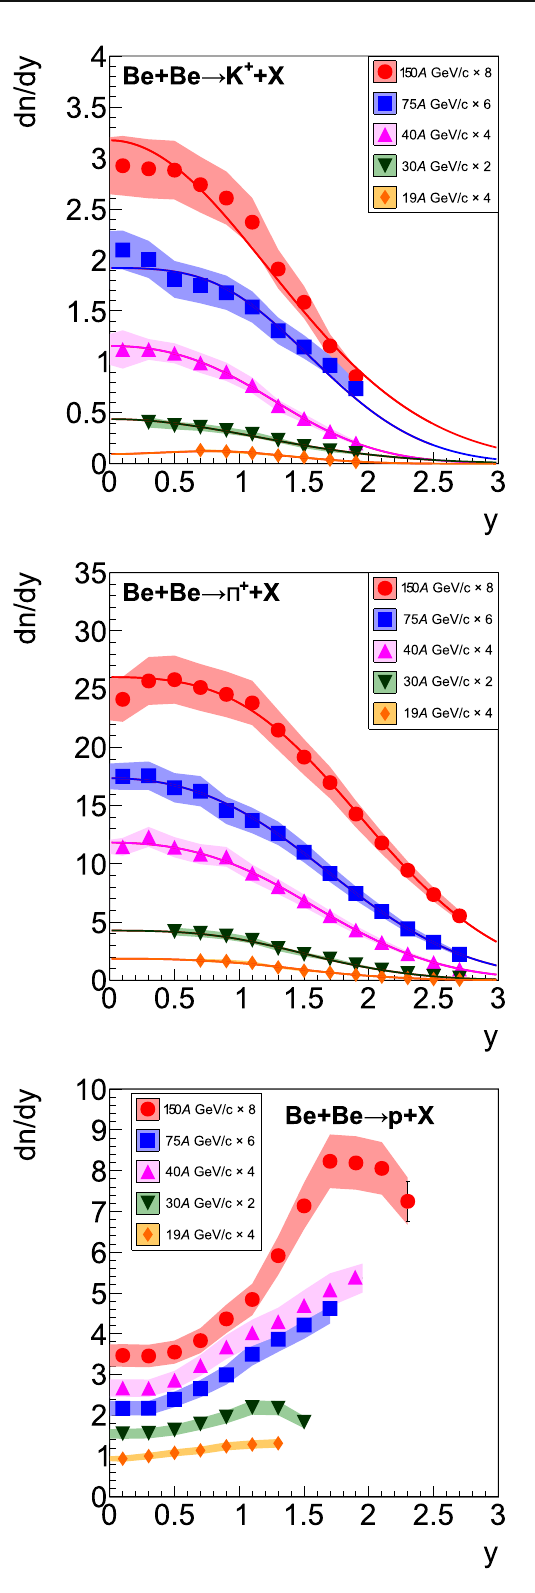
Fig. 30 Rapidity spectra of K + , K − , π + , π − , protons and antipro- tons produced in the 20% most central Be+Be collisions. Curves depict Gaussian fits used to determine mean multiplicities. Spectra for dif-